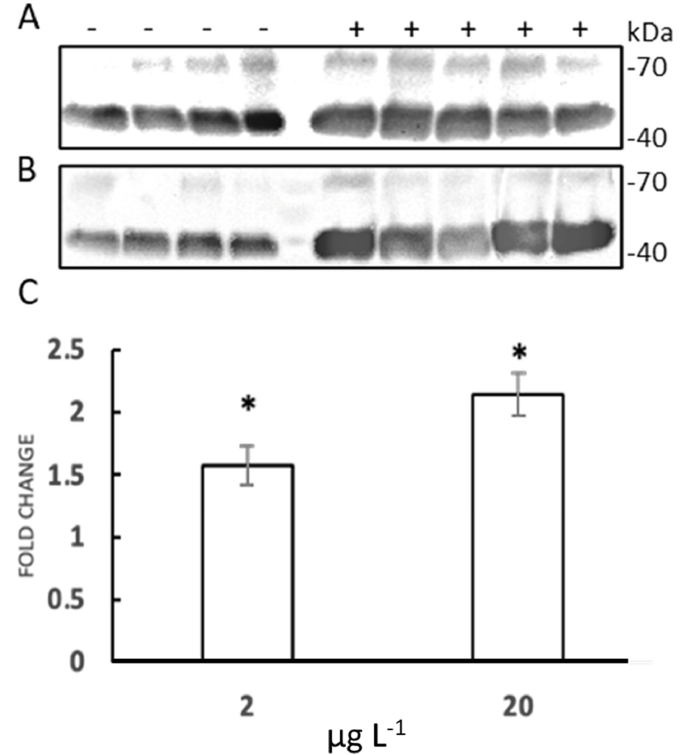
Figure 8. Effect of silver nitrate on HSP70 expression in gills. ( A ) Representative HSP70 Western blot analysis of gill SN20 extracts (30 µ g) from silver nitrate exposure (2 µ g L − 1 ). ( B ) Same as for A but 20 µ g L − 1 exposure level. Legend: (-) control reference; (+) silver nitrate exposed. ( C ) Densitometric analysis of HSP70 bands, average fold change +- SEM with respect to reference not exposed control specimens. * Mann–Whitney U-test, p < 0.01, n = 18.